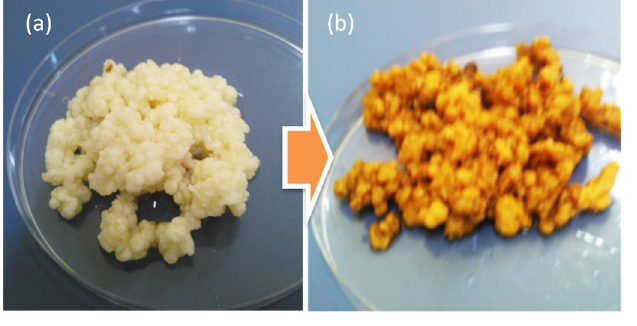
Figure 5. Morphology of kefir grains in the beginning of the initial fermentation cycle (FC) ( a ) and the end ( b ) of the final FC during the substrate substitution (milk from brown sugar solution).